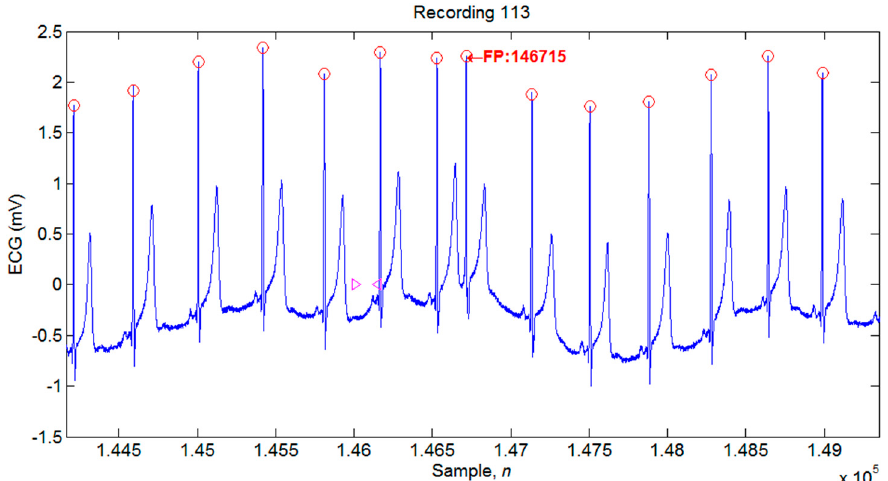
Figure 18. Illustration of the detection failures caused by QRS peaks but annotated as Not QRS peaks by the MIT-BIH Arrhythmia Database.